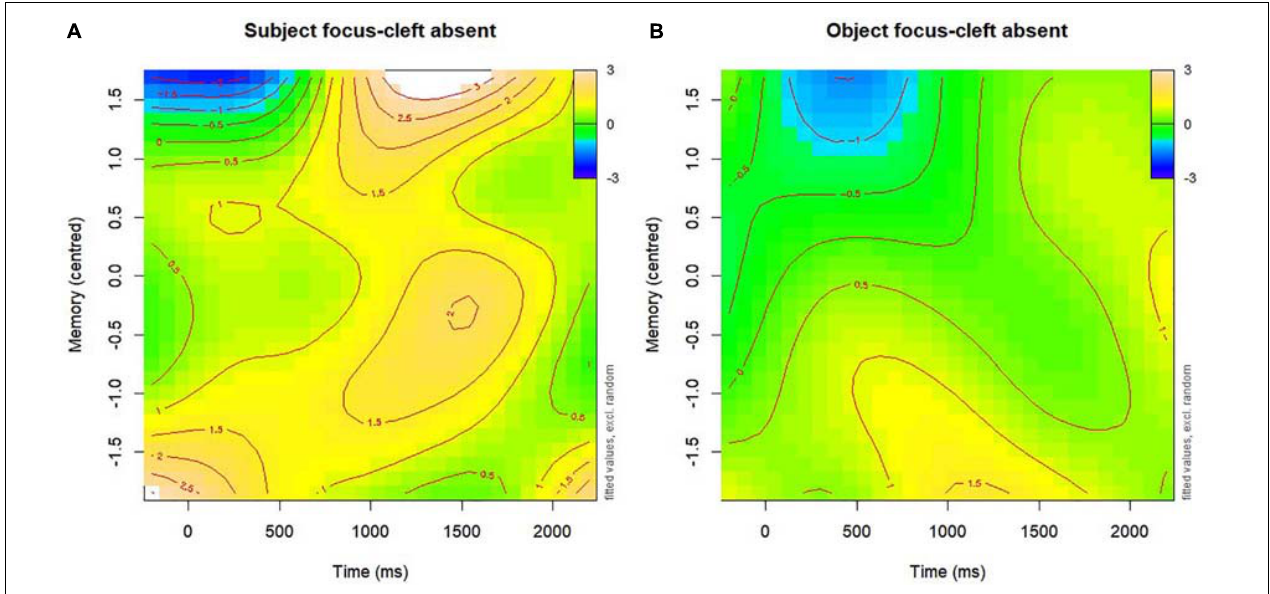
FIGURE 4 | Contour plots of three-way interactions between Time (x-axis), Memory Scores on the Nebraska barnyard task (y-axis) and subject focus-cleft absent (A) or object focus-cleft absent (B) conditions. Yellow indicates a subject preference, whereas green indicates a reduced subject preference. Blue colours represent object preference, but these are too minor to